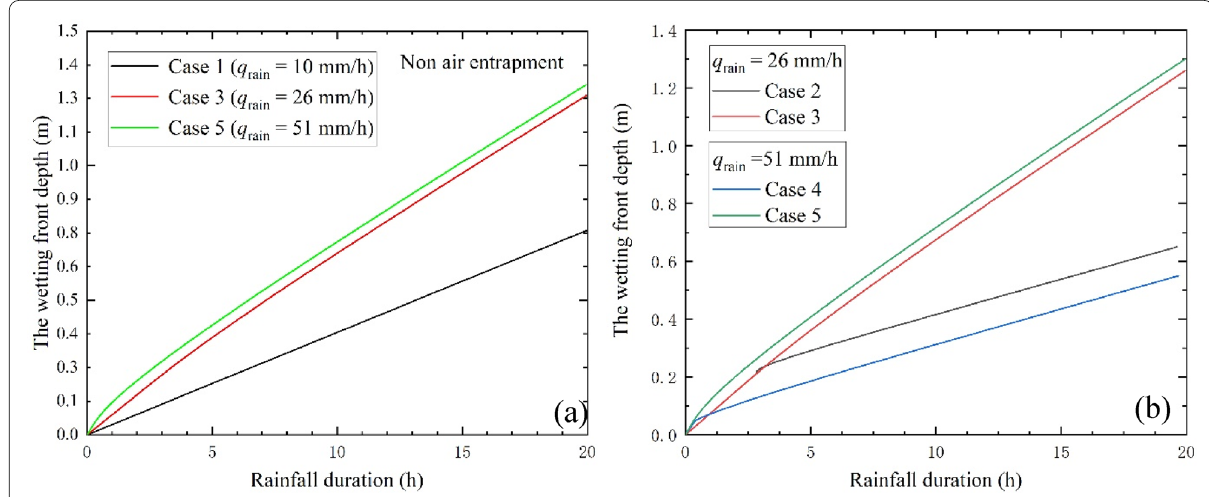
Fig. 7 Changes in the depth of the wetting front during rainfall